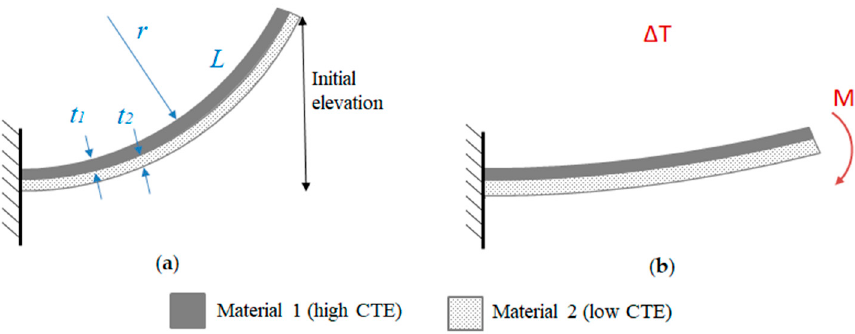
Figure 9. Bimorph actuator: operation principle ( a ) initial state; ( b ) under actuation.